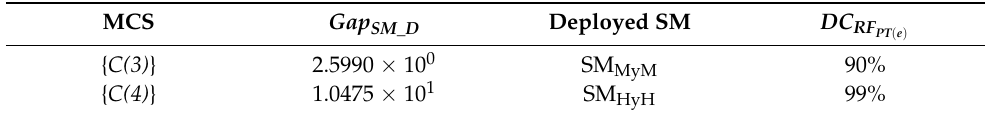
Table 5. Safety mechanism deployment for the PT according to DC RF MCS Gap SM_D Deployed SM DC RF